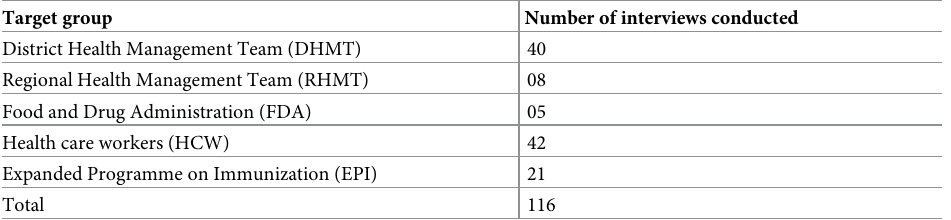
Table 1. Interviews